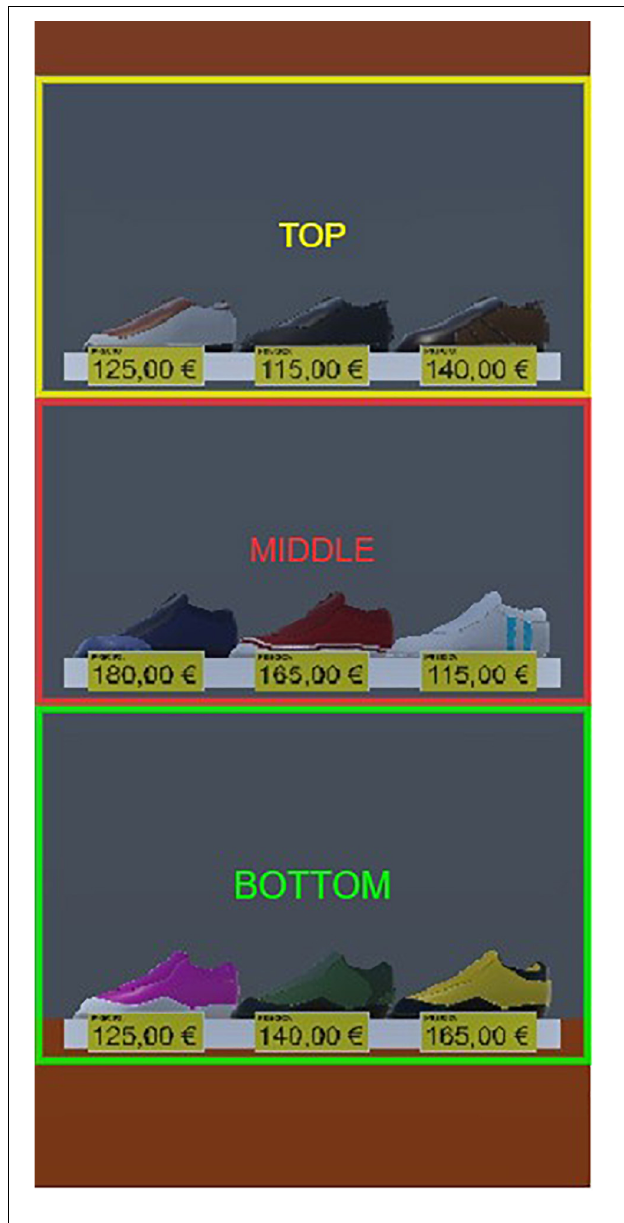
FIGURE 4 | Shelf with three levels of AOIs for Tasks 2 and